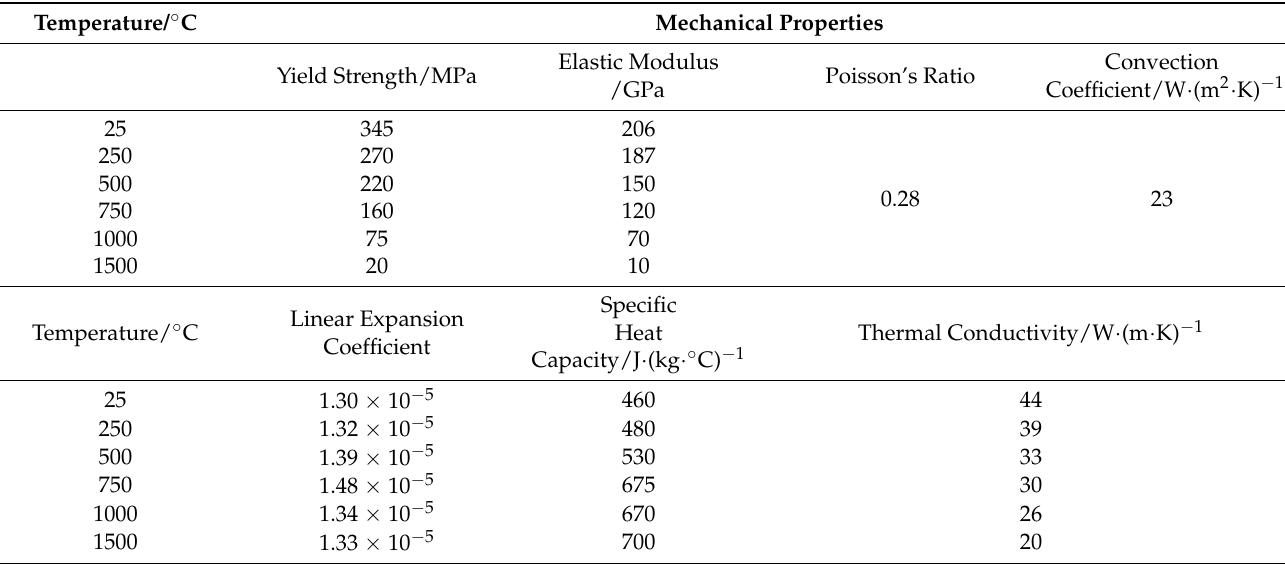
Table 1. Changes in the mechanical properties of the welding base metal at different temperatures [15].